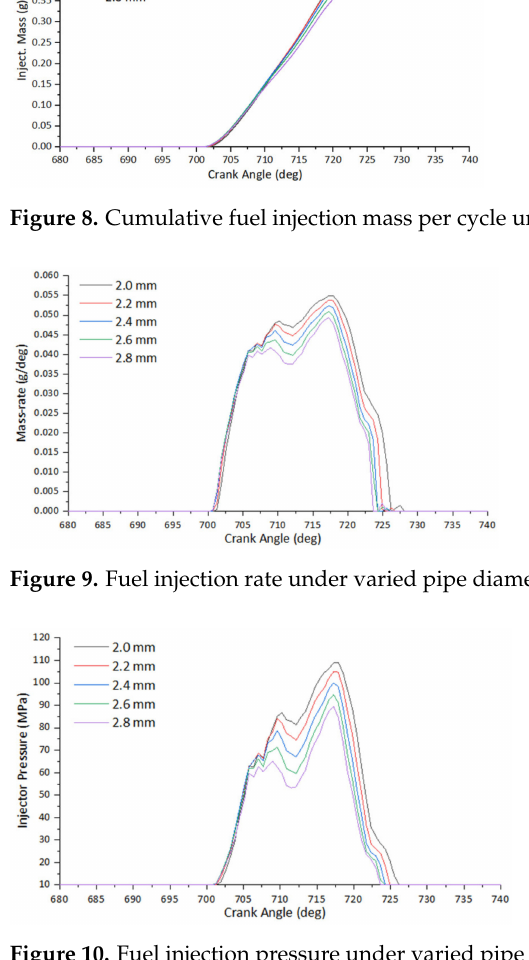
Figure 10. Fuel injection pressure under varied pipe diameters.